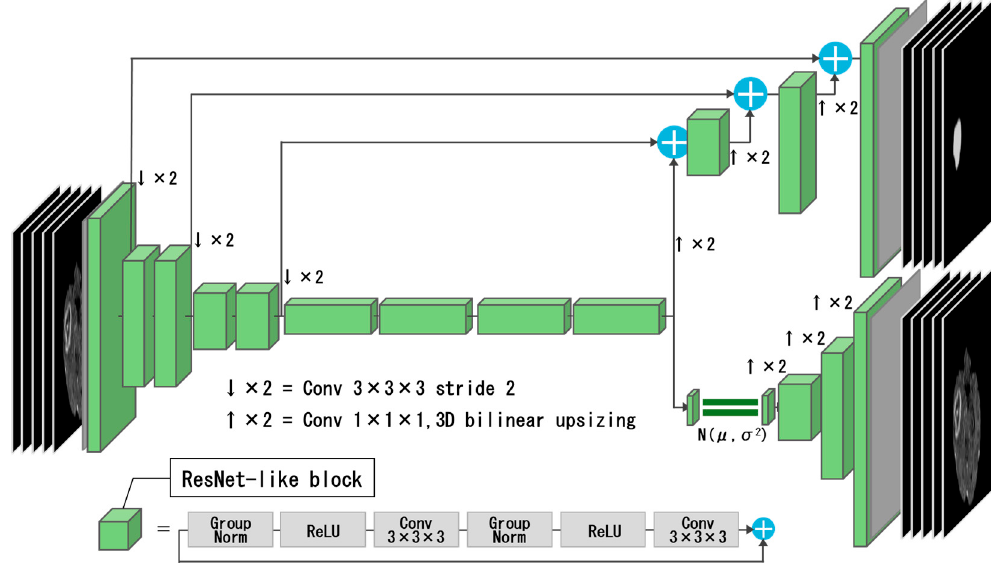
Figure 2. 3D CNN architecture used for extracting the brain tumor region. This model was provided by the Clara project developed by NVIDIA. It comprises ResNet-like blocks and skip connections.